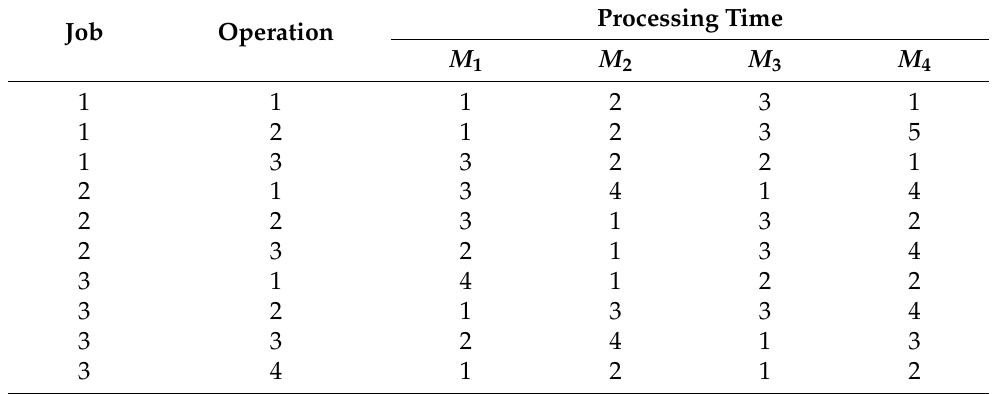
Table 2. Flexible job shop scheduling problem ( FJSP T ) instance: 3 jobs, 10 operations and 4 machines.